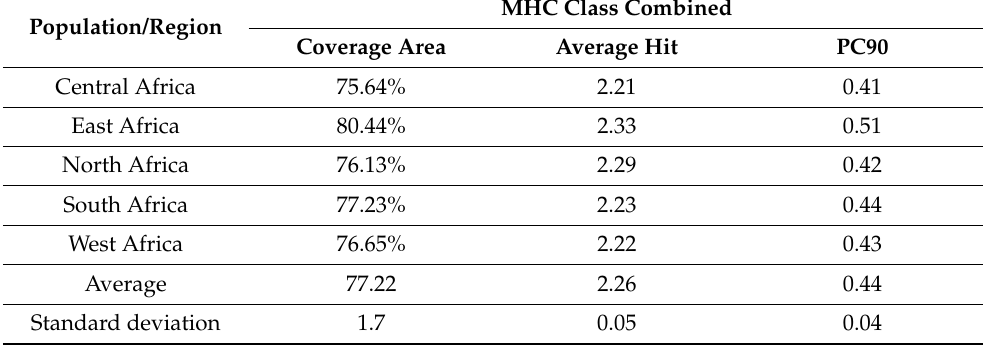
Table 3. IEDB server predicted results.